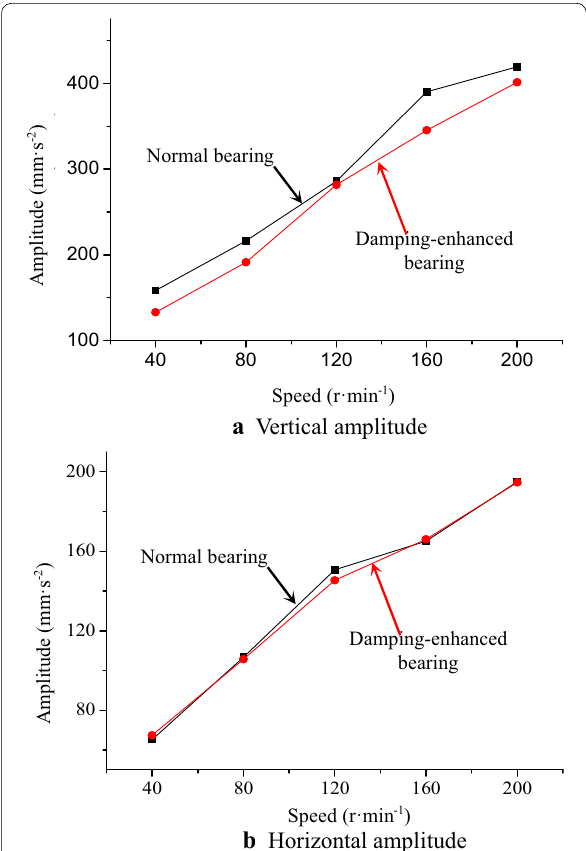
Figure 12 Variation of vibration amplitude with shaft speed. a Vertical amplitude b Horizontal